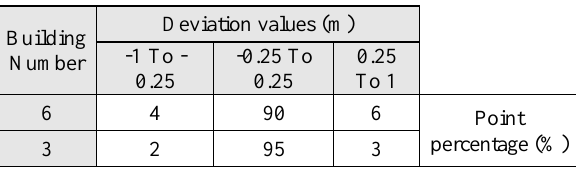
Table 3. Analysis of the deviation distribution